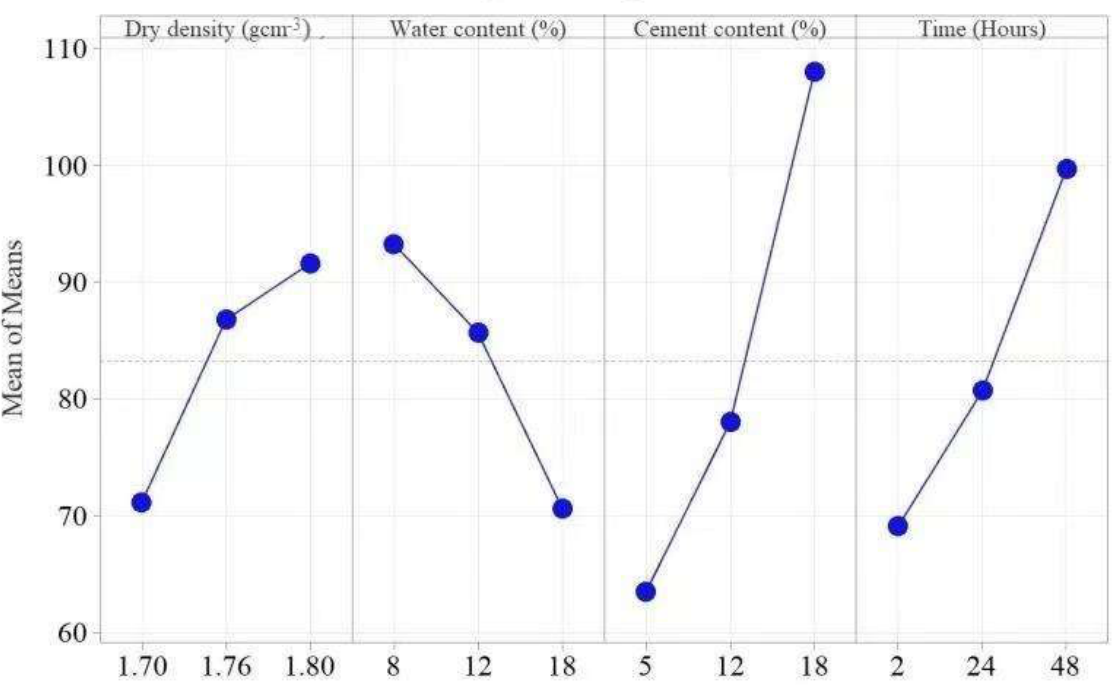
Figure 8. Effects of the control factors on the ρ .